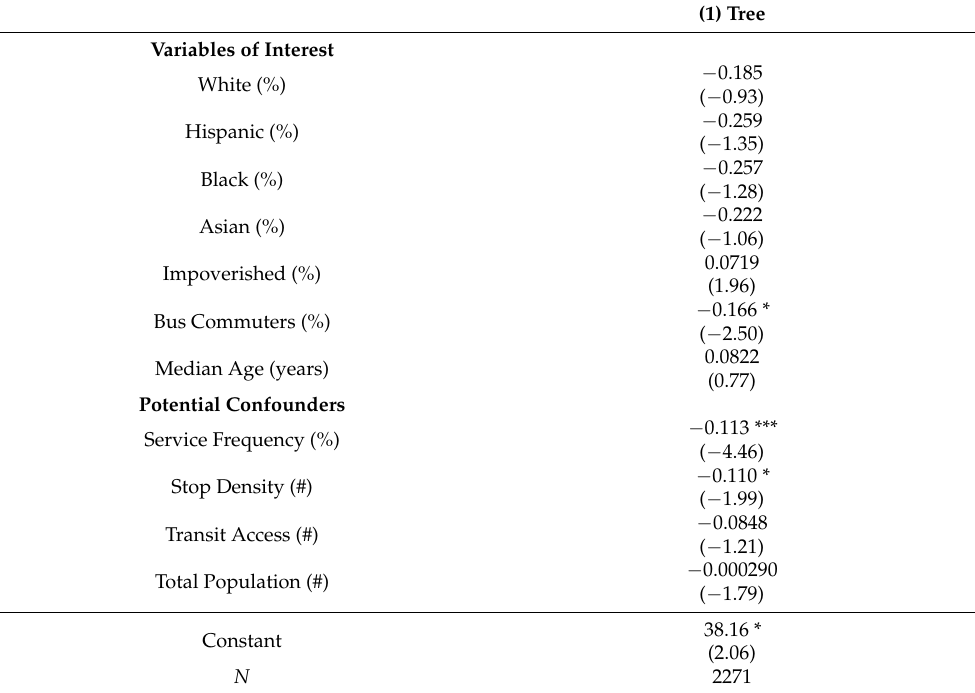
Table 4. Model output for relations between sociodemographic characteristics and tree canopy surrounding bus